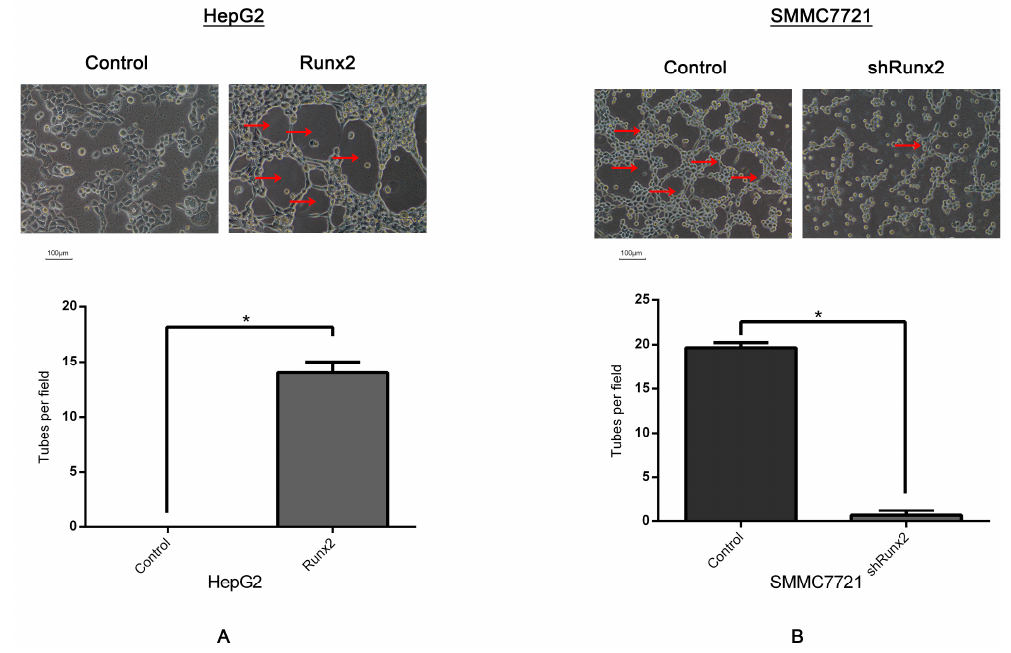
Figure 5. Three-dimensional culture on Matrigel matrix (×200; bars 100 µm), VM-like tubes are pointed by Red arrows ( A ) VM-like tube formation in HepG2-Runx2 compared with HepG2-control cells; ( B ) decreased number of VM formation of SMMC7721-shRunx2 compared with SMMC7721-control cells. (* p < 0.05).